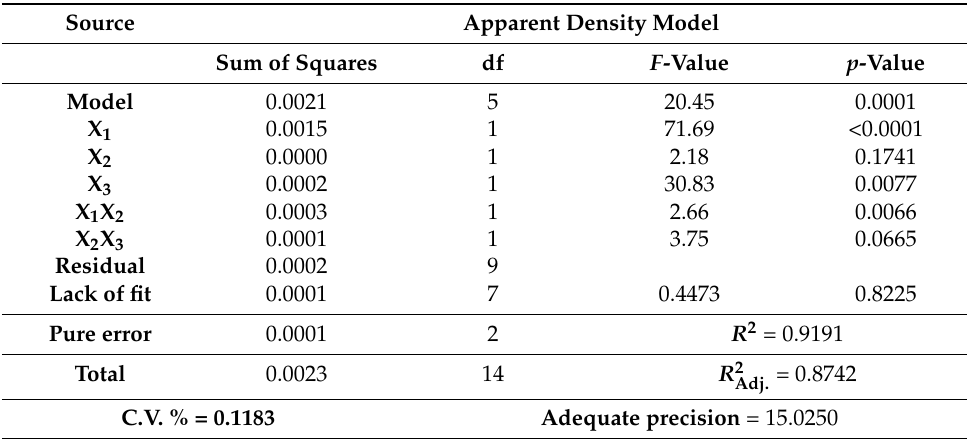
Table 4. ANOVA results for fitted regression model of monitored